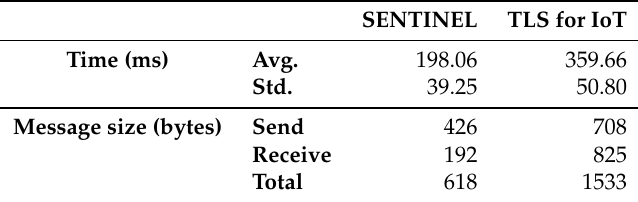
Table 3. Evaluation results of mutual authentication and key agreement